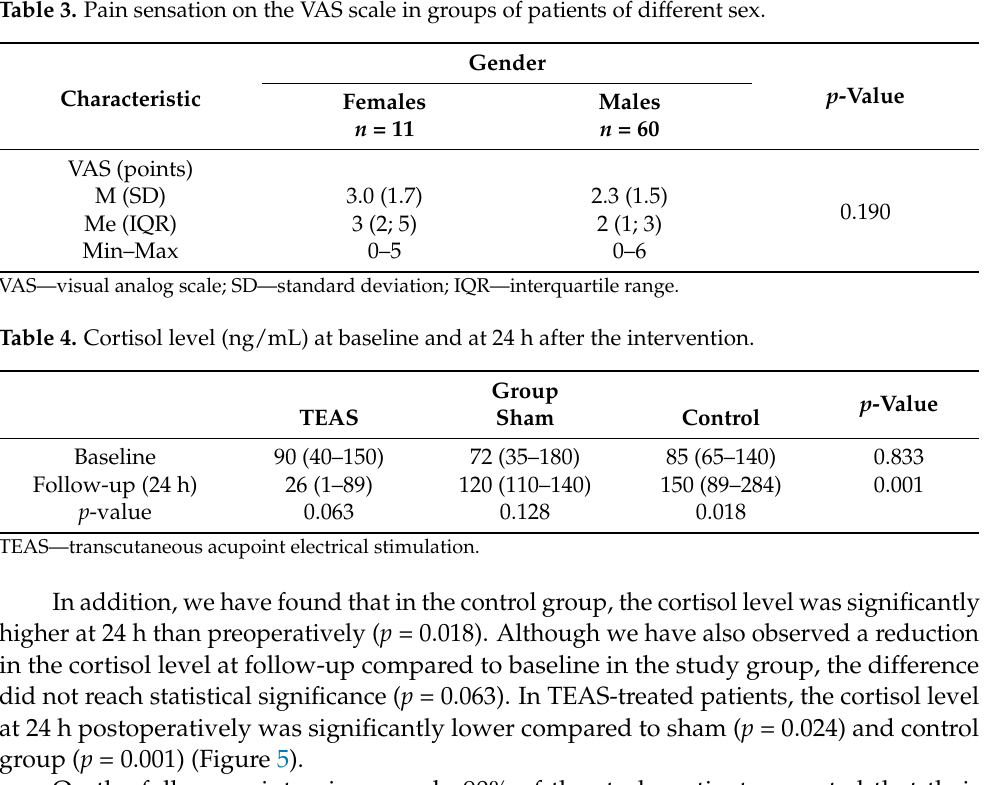
Figure 4. Correlation diagram between perceived pain and dose of morphine, Pearson’s correlation coefficient, and the regression line equation. VAS—visual analog scale (pain intensity quantified in points); TMD—total morphine (dose in milligrams). Table 3. Pain sensation on the VAS scale in groups of patients of different sex.